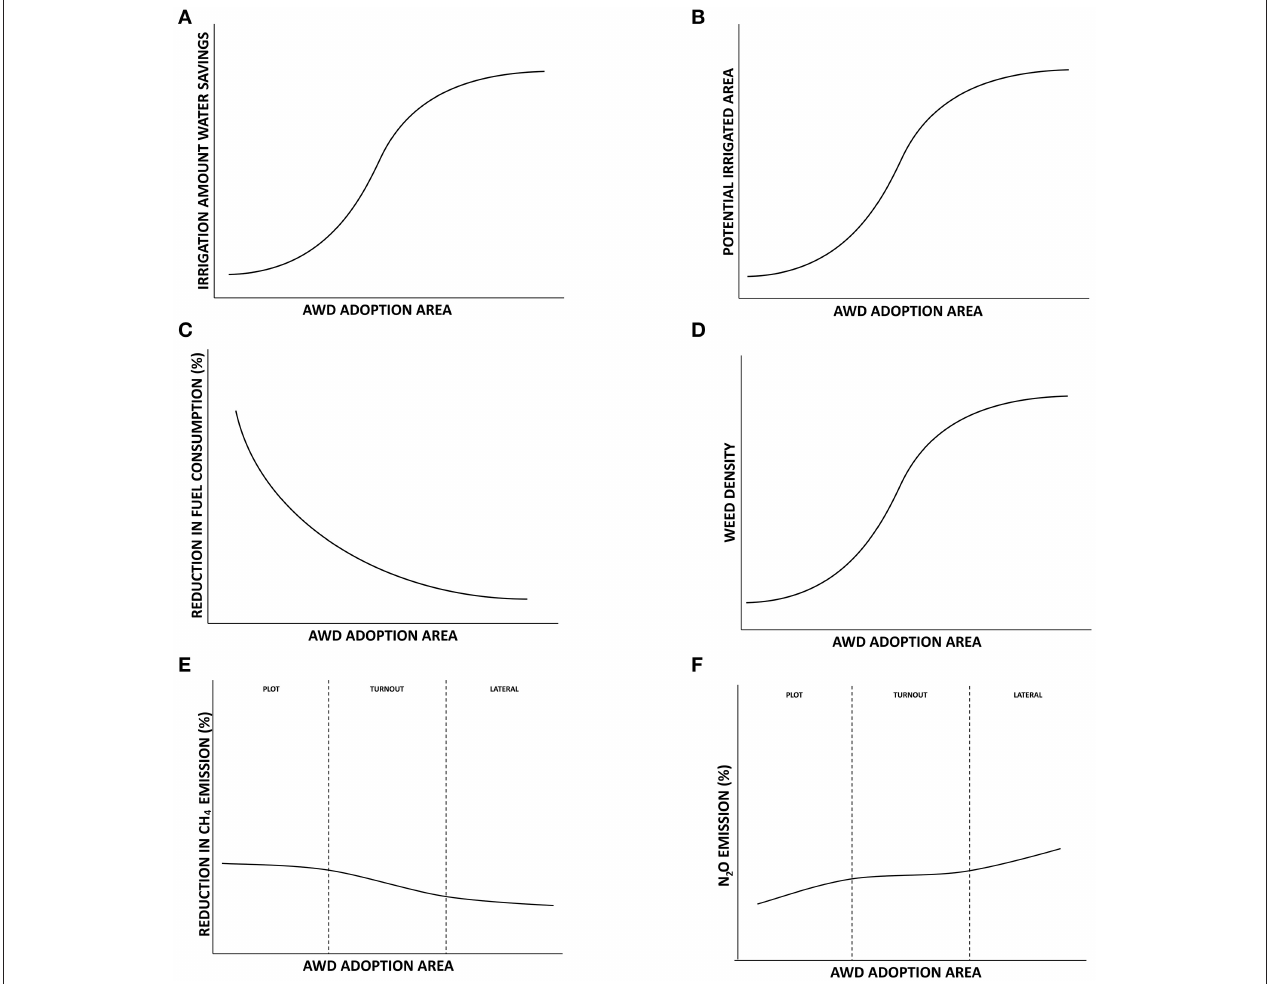
FIGURE 4 | Synergies and trade-offs in AWD adoption by (A) irrigation amount savings, (B) potential irrigated area, (C) reduction in fuel consumption, (D) weed density, (E) reduction in methane emission, and (F) nitrous oxide emission. Graphs represents the generic trend and the responses may vary with diverse agro-environment (Sources: